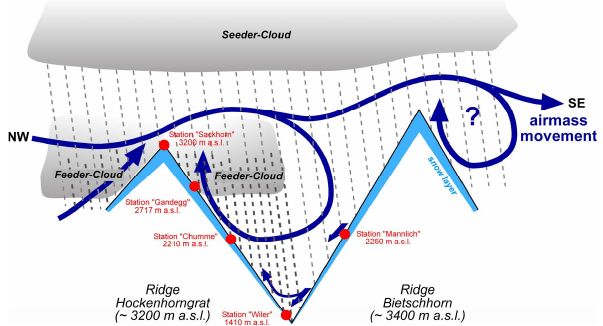
Figure 6. Schematic depiction of our interpretation of the atmo- spheric conditions. The question mark indicates that a second cav- ity circulation might be present in the adjacent valley, but of that we have no